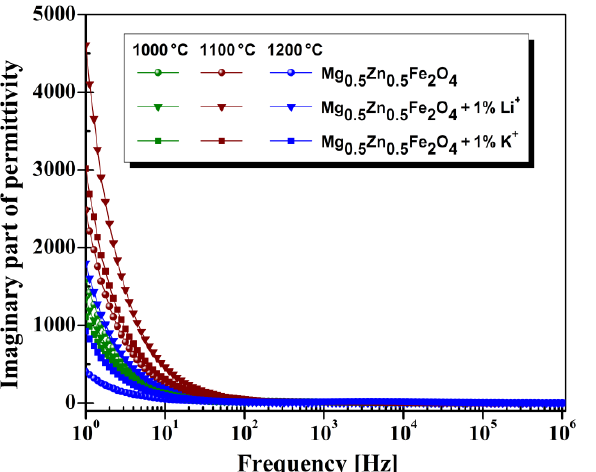
Figure 6. Imaginary part of permittivity vs. frequency for investigated magnesium-zinc ferrites.